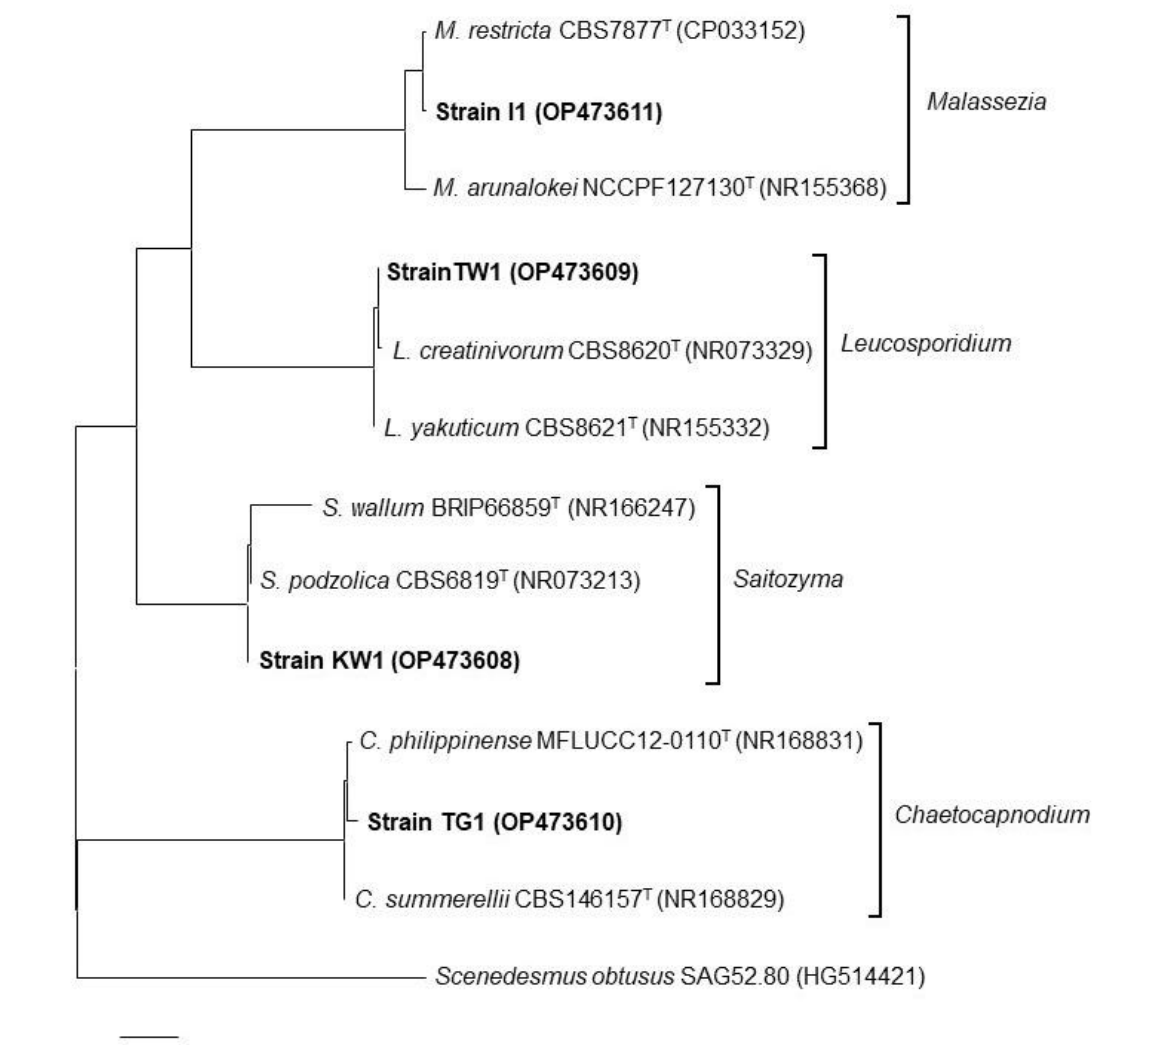
Figure 5. Phylogenetic tree of the isolated strains (indicated in bold) with its known neighbors based on ITS sequences constructed using the maximum-likelihood method. The scale bar represents an evolutionary distance (Knuc) of 0.05. Accession numbers are indicated in parentheses for each DNA sequence.